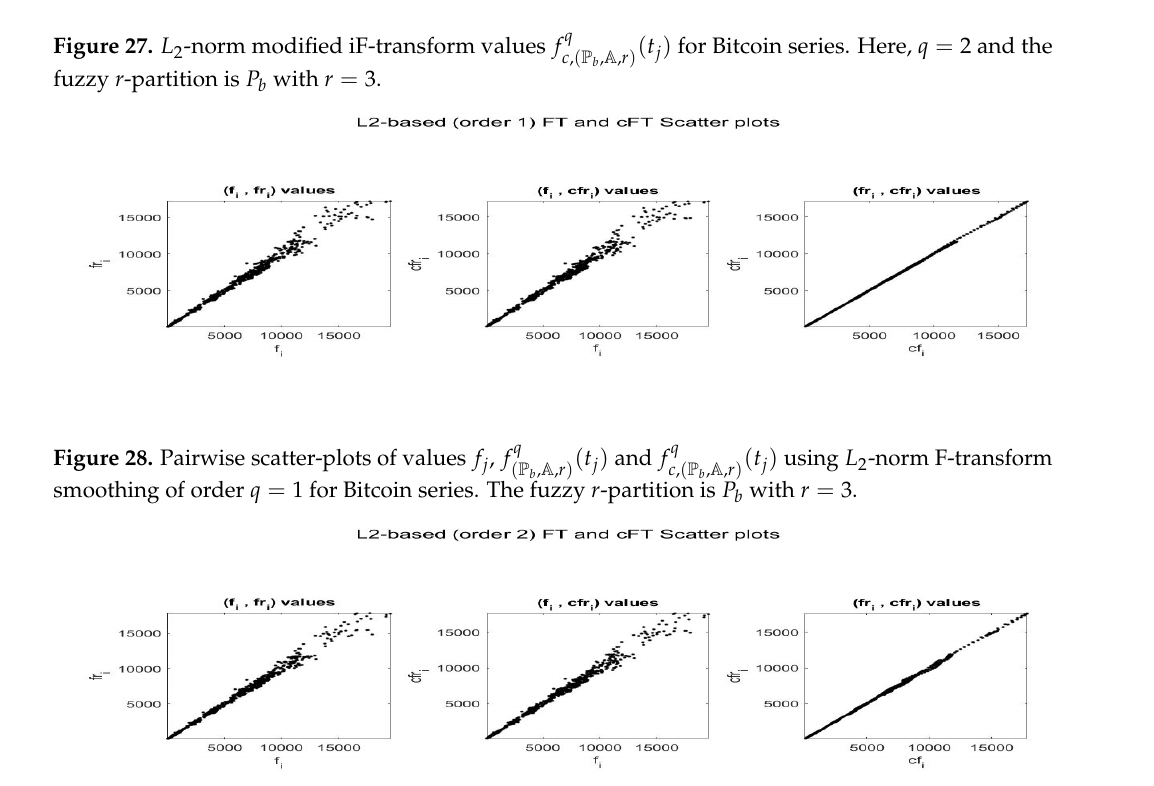
( t ) for Bitcoin series. Here, q = 2 and the j c , ( P b , A , r )